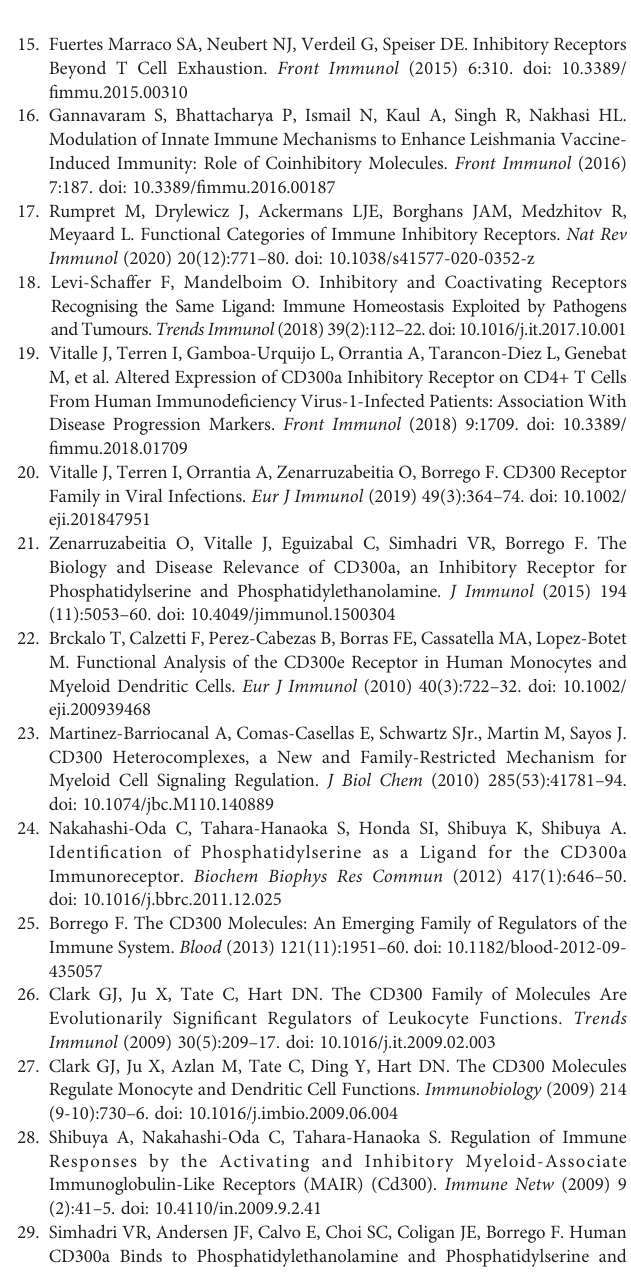
Supplementary Figure 3 | TheproliferationofantigenexperiencedCD4 + andCD8 + T cells co-cultured with macrophage in the presence and absence of anti-CD300a antibodies. The CD300a receptor blocking signi fi cantly enhanced their proliferation. Supplementary Figure 4 | The mRNAs expression levels of pro and anti- in fl ammatory cytokines, and MHC genes in the spleen of infected mice. The CD300a receptorblocking in L. donovani infectedmice induced the IFN- g and IL-12 (A, B) while inhibited IL-4 and IL-10 mRNAs expression levels (C, D) in their spleen. TheCD300a blocking also induced the expression of both MHCI and MHCII genes in the spleen of parasite infected animals (E, F) . Supplementary Figure 5 | The liver granuloma formation in anti-CD300a antibodies treated mice. The arrows indicate the macrophage in fi ltration i.e., the granulomatous portion in the tissue sections. The CD300a blocking signi fi cantly reduced the granuloma formation at the later days of